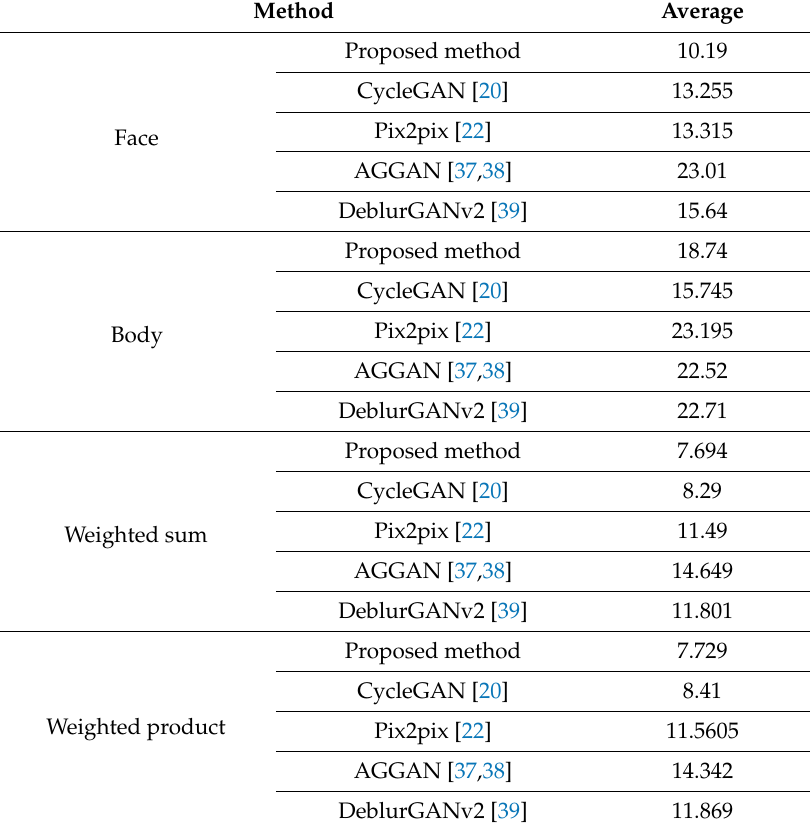
Table 7. Comparisons of EER for recognition by proposed method with those by other GAN-based methods in DFB-DB2 (unit: